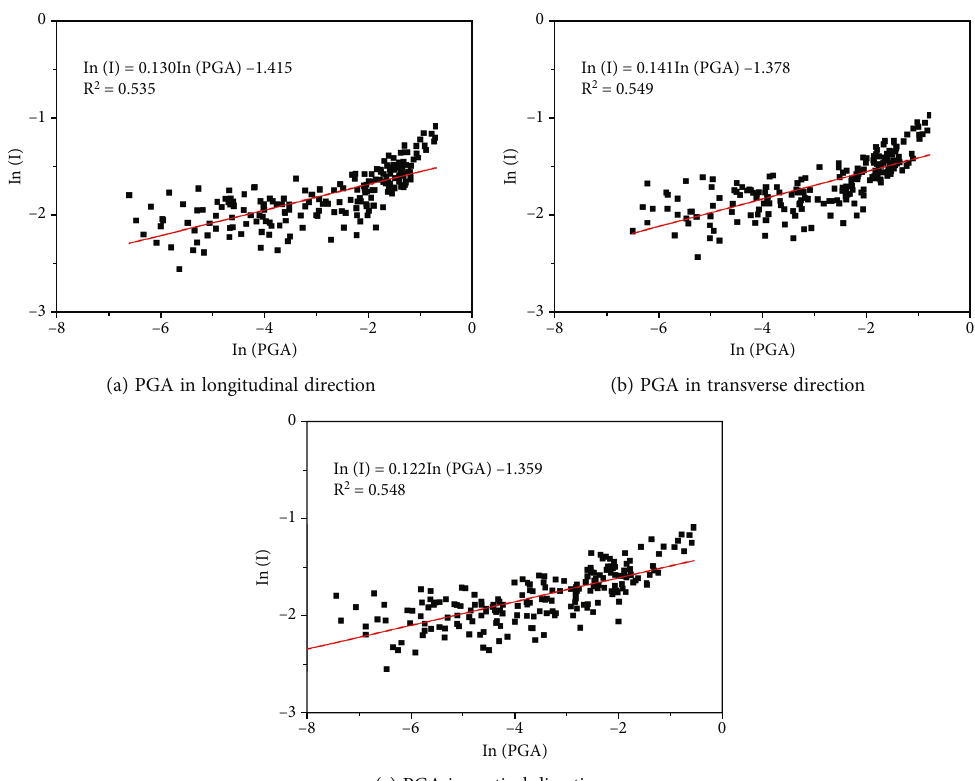
Figure 9: Plotted logarithm relationship of intensity of non-near-fault ground motions vs. damage to the